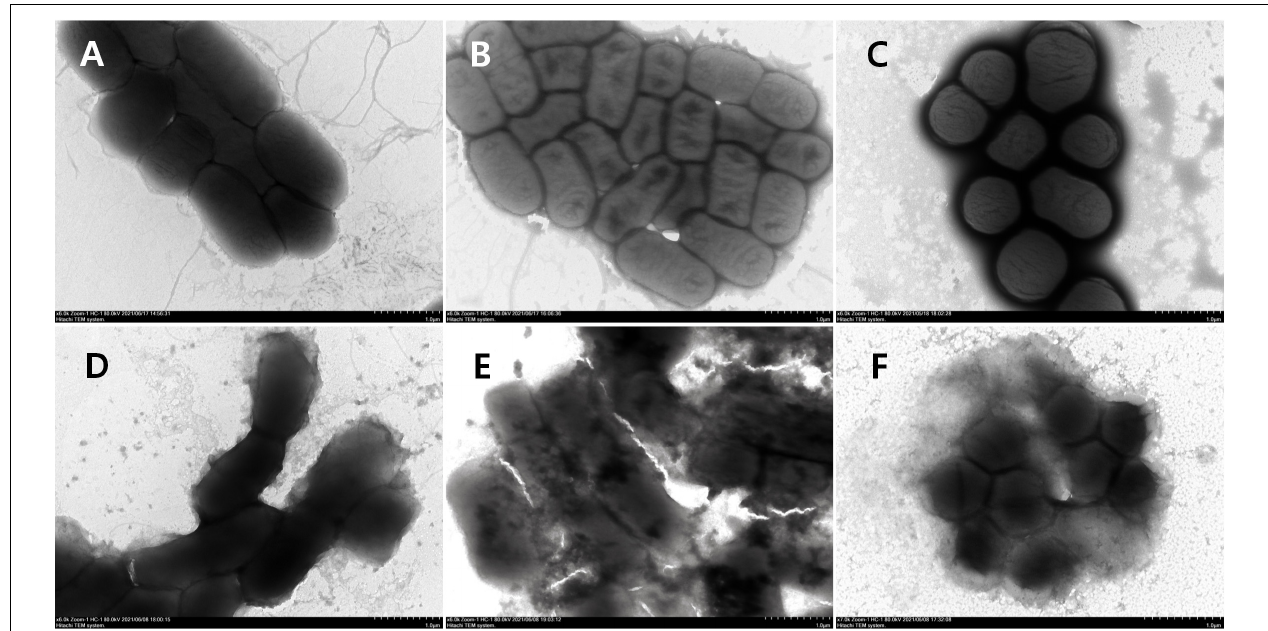
FIGURE 12 | TEM observation of bacterial morphology. (A) E. coli (CMCC44103), (B) E. coli (SYPB-3820), (C) S. aureus (CMCC26003), (D) E. coli (CMCC44103) treated with S1, (E) E. coli (SYPB-3820) treated with S2, (F) S. aureus (CMCC26003) treated with